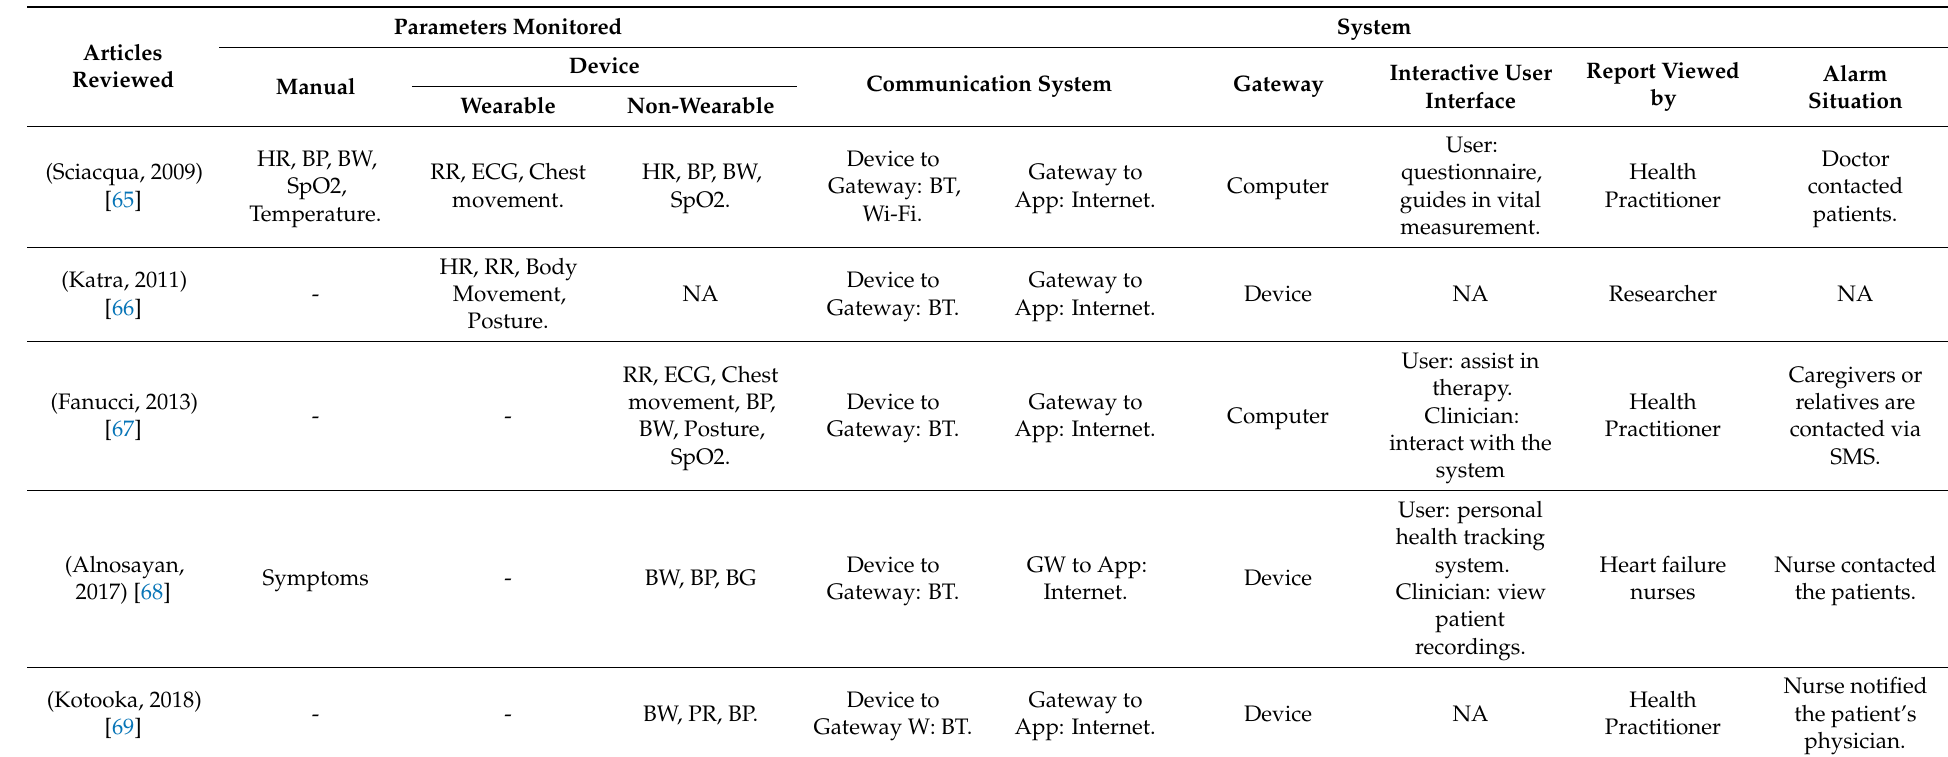
Table 3. Smart Home Technology and monitored